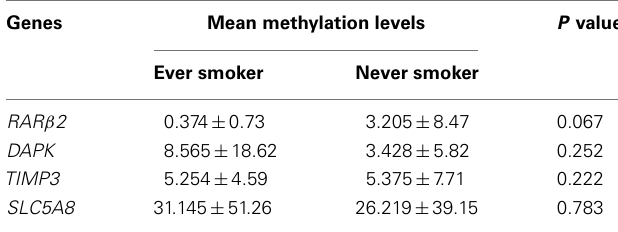
Table 4 | Comparison of methylation levels for the indicated genes in papillary thyroid cancer between ever and never